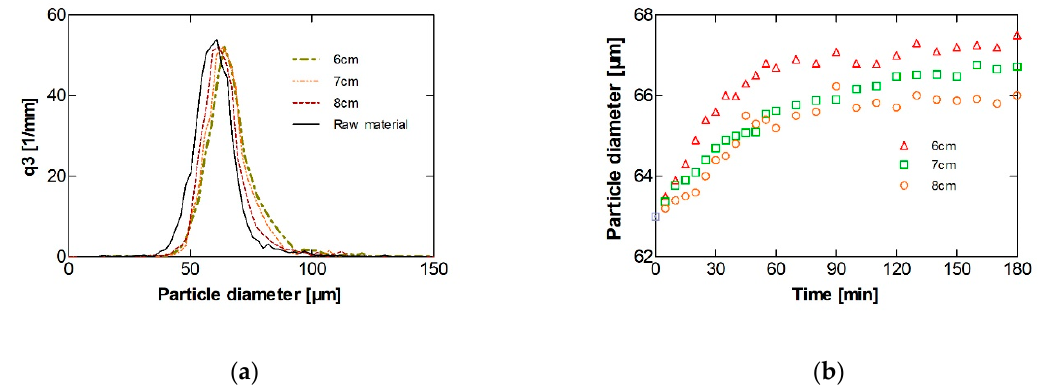
Figure 14. ( a ) Particle size distributions and ( b ) evolution of average particle diameter d 1,3 for different aerosol inlet tube lengths.